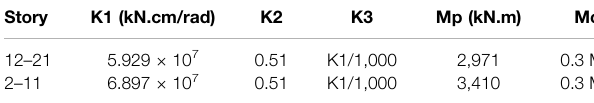
TABLE 2 | Beam-end nonlinearity.